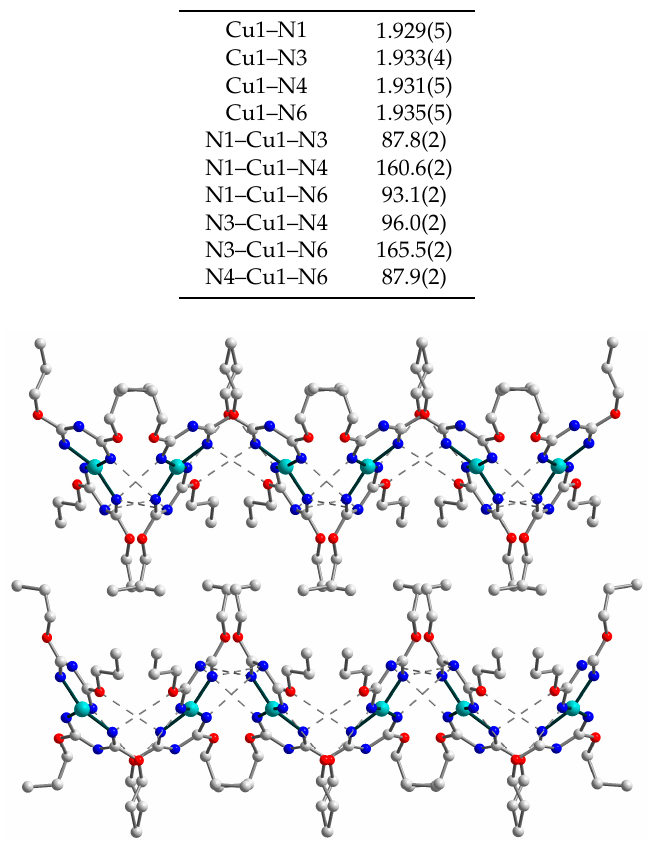
Figure 3. Representation of the packing of supramolecular layers in 3 down the c axis. H atoms are omitted for clarity. Colour scheme: Cu, cyan; O, red; N, blue; C, grey.